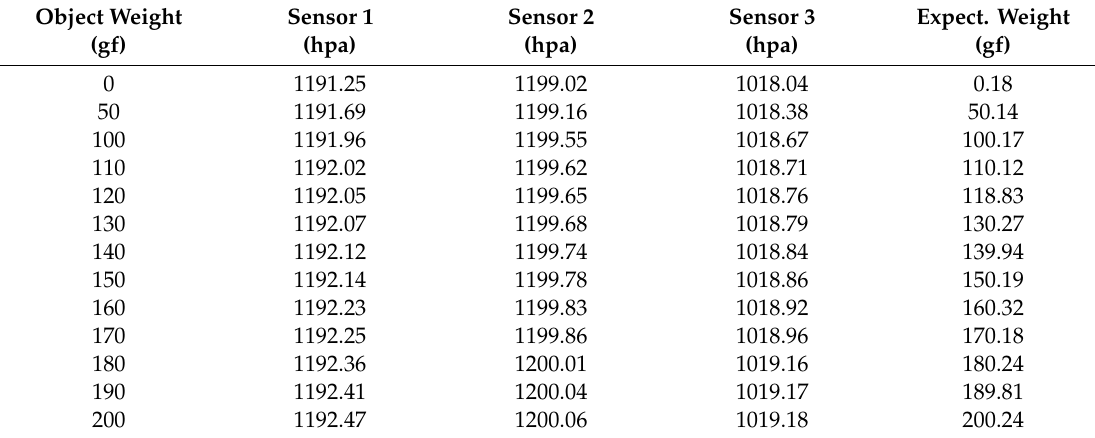
Table 1. Weight expectation by deep neural network (DNN).